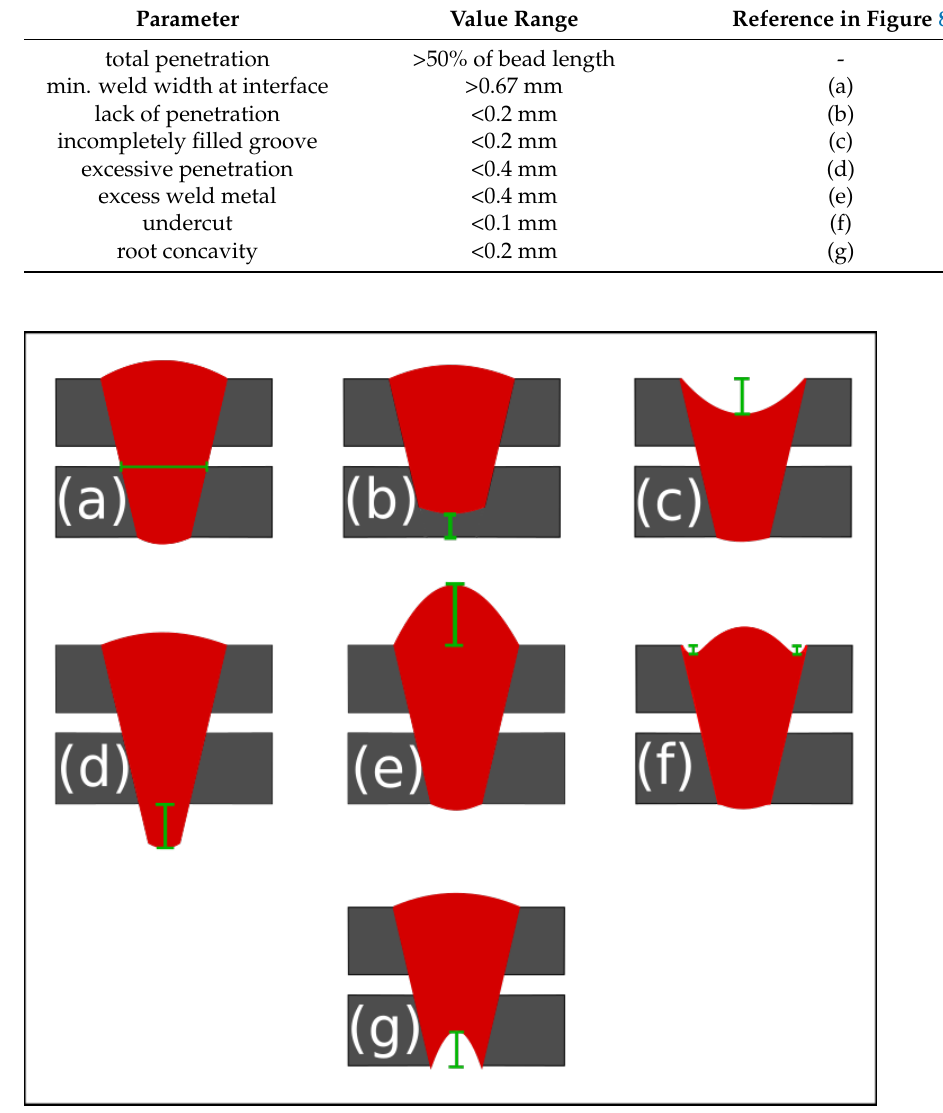
Figure 8. Quality requirements. Sub-Figures ( a – g ) are described in detail in Table